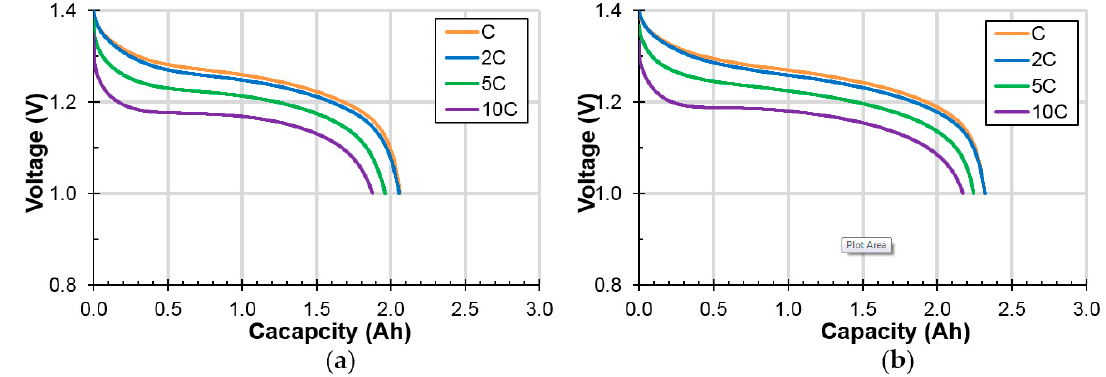
Figure 5. Discharge voltage profiles at different discharge rates of ( a ) cell A, and ( b ) cell B measured at room temperature.